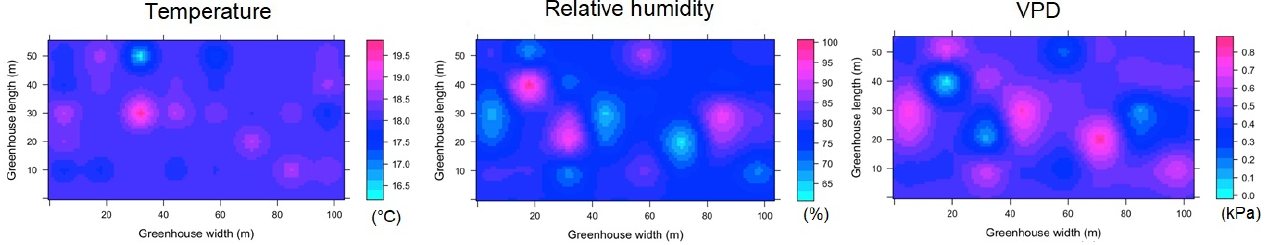
Figure A3. Spatial distribution predicted by kriging, for temperature, relative humidity and VPD in MG and for ESRL 4.